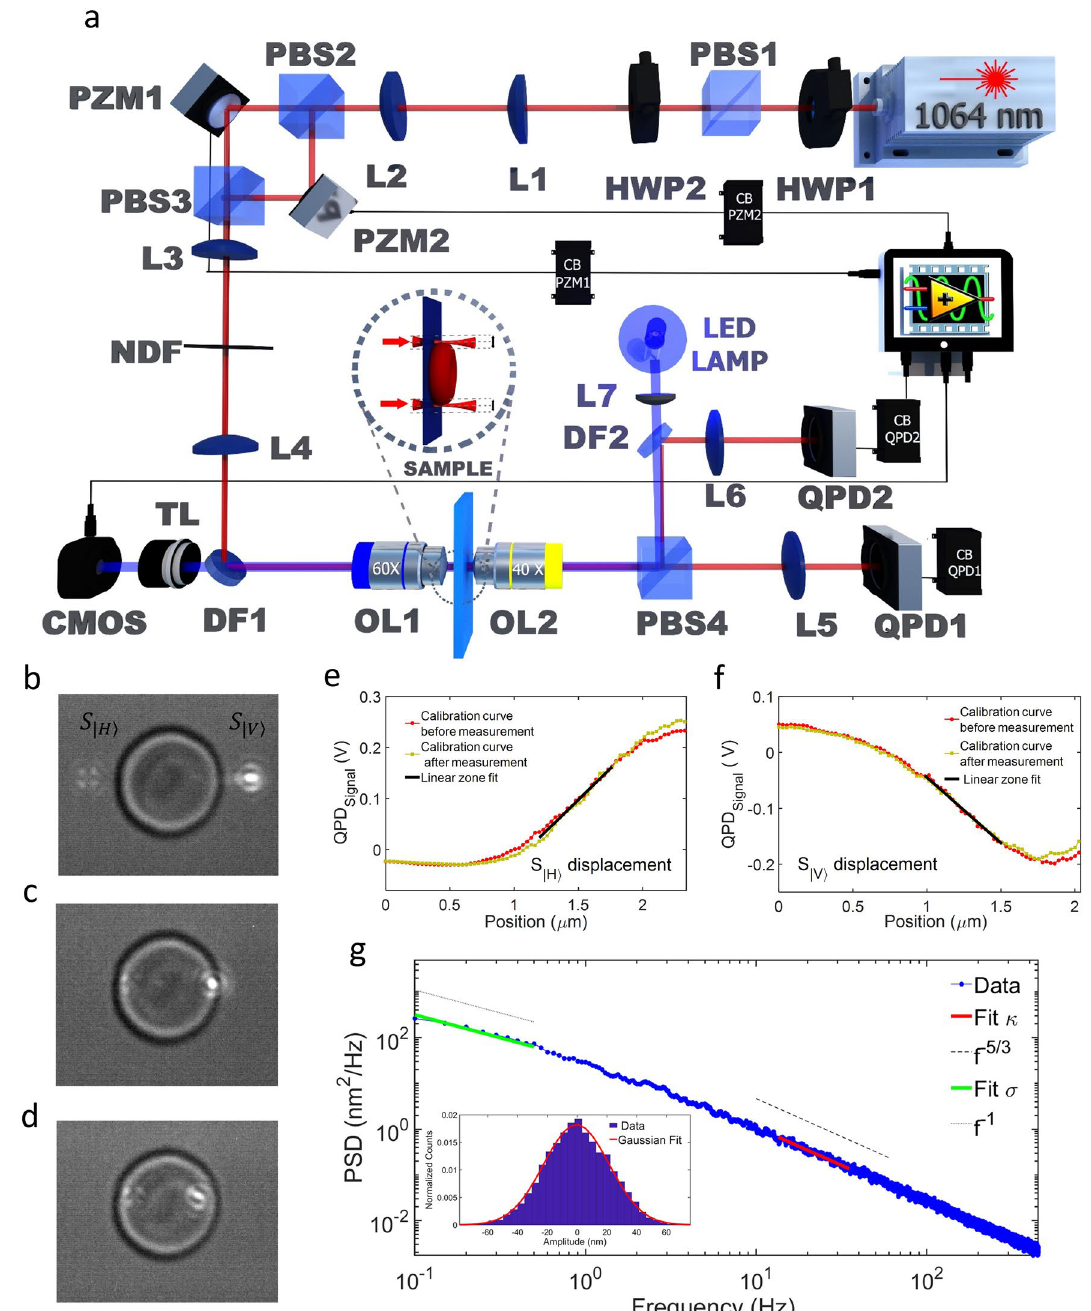
Figure 1. Experimental setup and method. ( a ) Instrumental setup used for fluctuation measurements. For component abbreviations, see “Materials and Methods” section ( Instrumental Setup ). ( b , c , d ) View of calibration curve acquisition for S | H � and S | V � . As each laser spot enters the RBC, it begins to appear on each signal as a linear zone, as is shown in ( e ) and ( f ) ( Matlab ver. 2018b ). In this zone, the position changes are linearly proportional to the voltage changes in each QPD. The conversion factor Volt to nm for each spot was obtained by using the inverse of the slope (solid black line). ( g ) Example of an average power spectral density (PSD) by calculating the individual PSDs of 20 position files of 10 s each at 20 kHz of acquisition rate over a single RBC ( Matlab ver. 2018b ). Normal theoretical functions and experimental fits for low and high frequencies (under 1 Hz and over 10 Hz, respectively) are shown in accord with the plane membrane model, where low- and high- frequency zones allow the tension (σ) and bending modulus (κ) experimental values to be obtained. Theoretical functions correspond to f −1 (dotted line) and f −5/3 (dashed line), respectively, where their experimental fits have been indicated for solid lines (green and red),